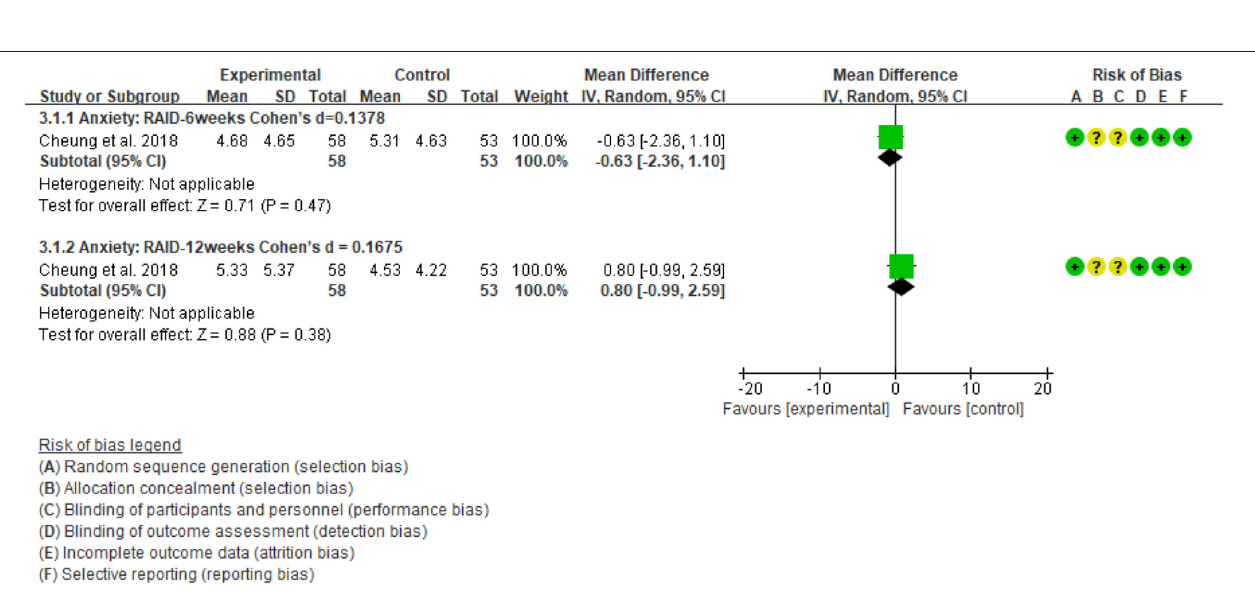
FIGURE 10 | The intervention group vs. the control group on anxiety rating